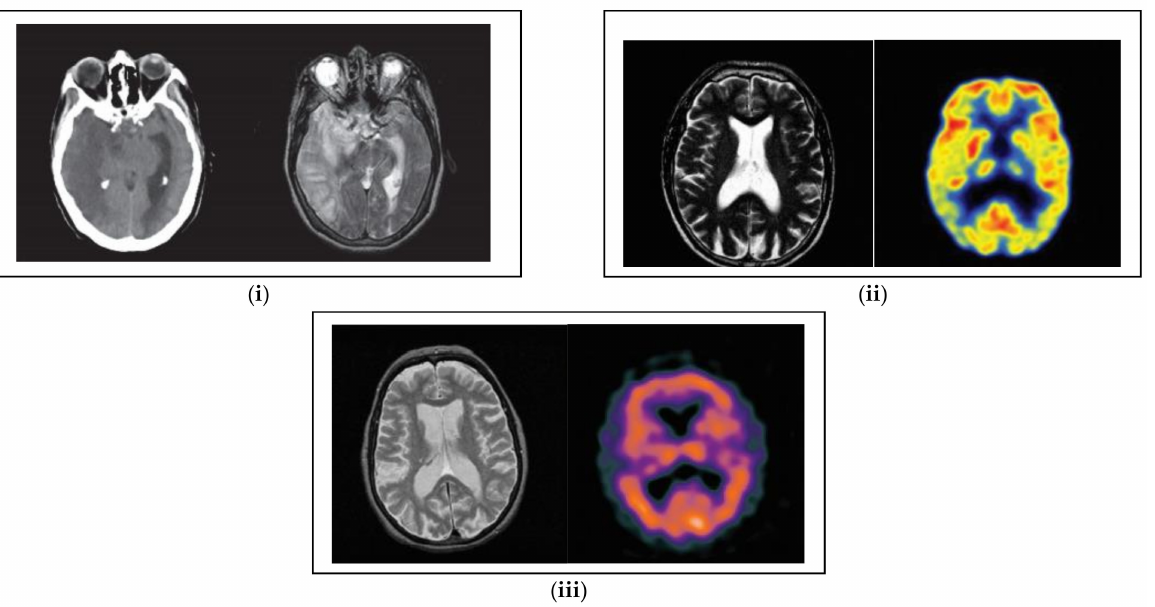
Figure 3. Database image ( i ) CT and MRI, ( ii ) MRI and PET, and ( iii ) MRI and SPECT.